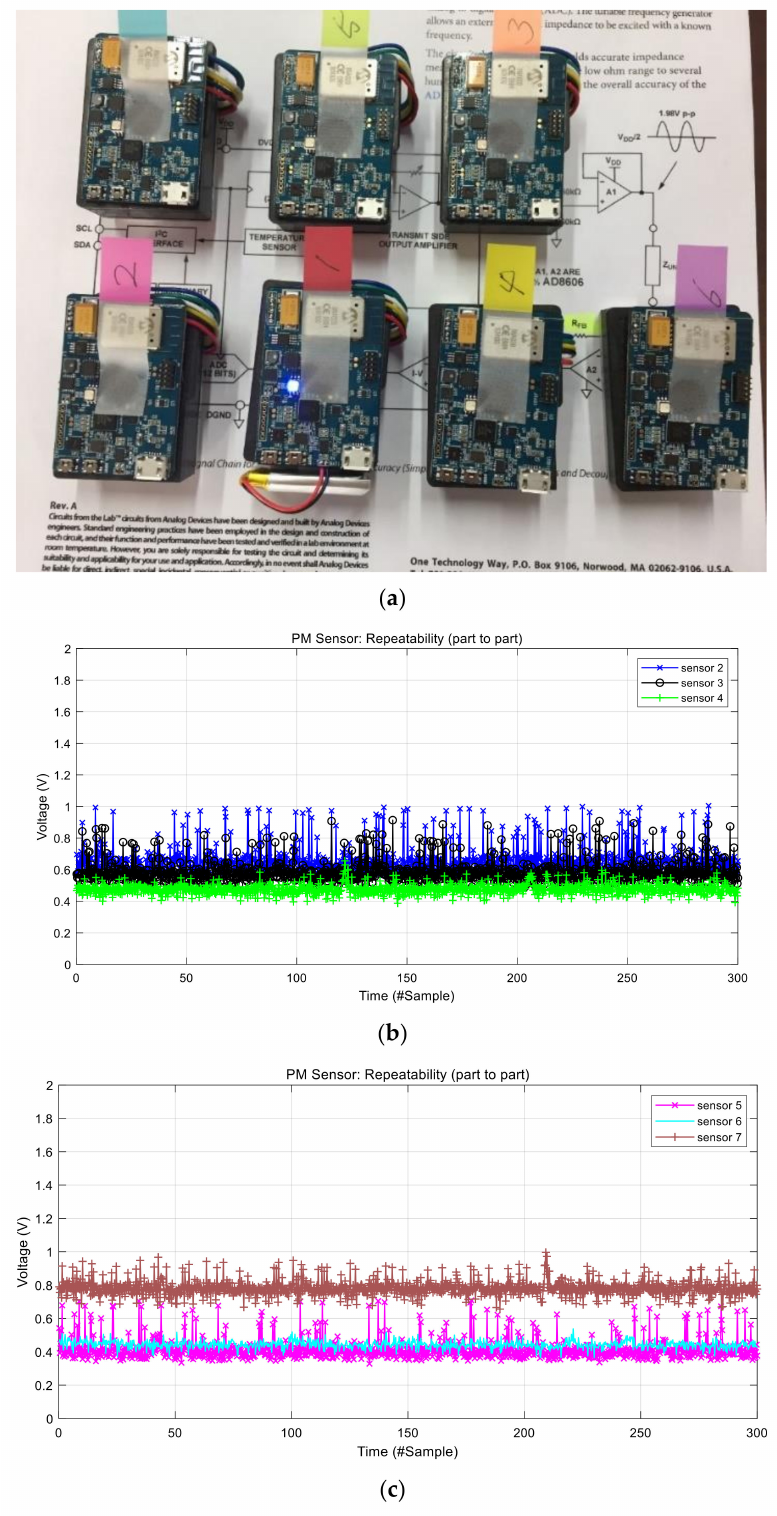
Figure 4. Experiment and output signals: ( a ) experiment environment, and ( b , c ) raw voltage data measured by the